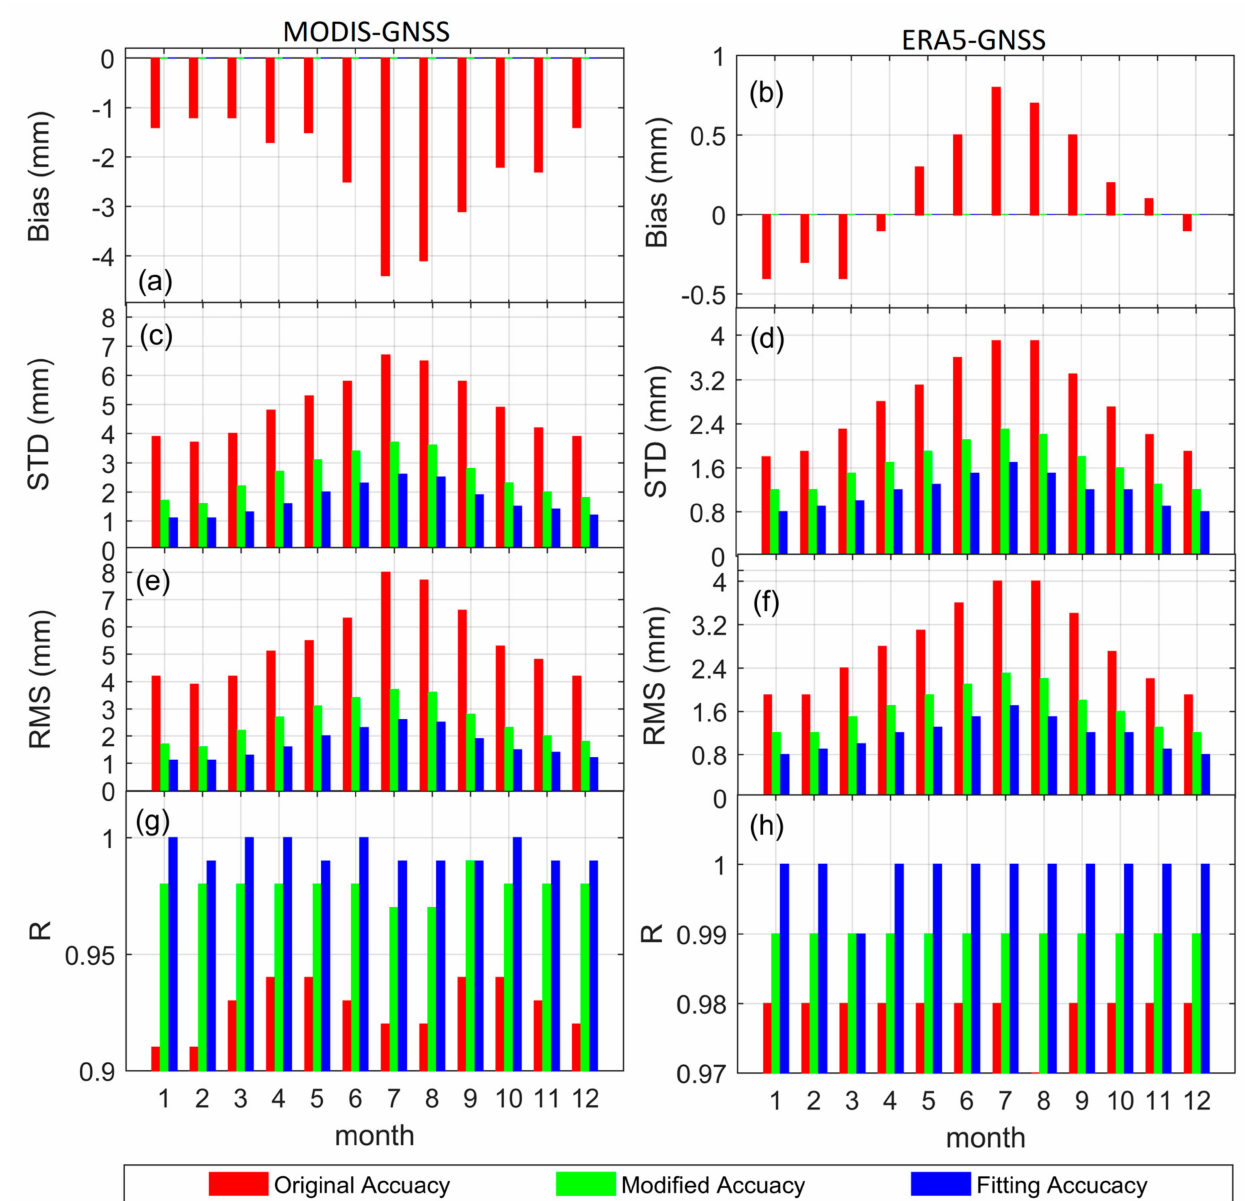
Figure 5. Accuracy information of the monthly models in different months. ( a ) Bias of the MODIS-GNSS model; ( b ) STD of the MODIS-GNSS model; ( c ) RMS of the MODIS-GNSS model; ( d ) R of the MODIS-GNSS model; ( e ) Bias of the ERA5-GNSS model; ( f ) STD of the ERA5-GNSS model; ( g ) RMS of the ERA5-GNSS model; ( h ) R of the ERA5-GNSS